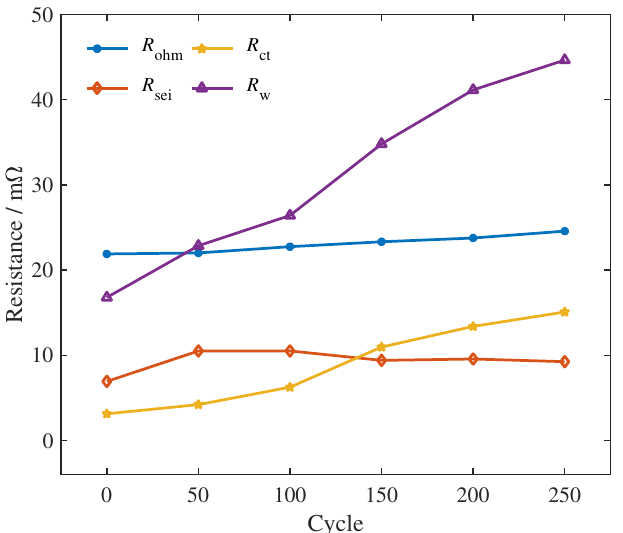
Figure 6. Impedance fitting results under 45 ◦ C@0.5–1 C condition obtained at 20% SoC with 500 mA excitation based on the second-order equivalent circuit